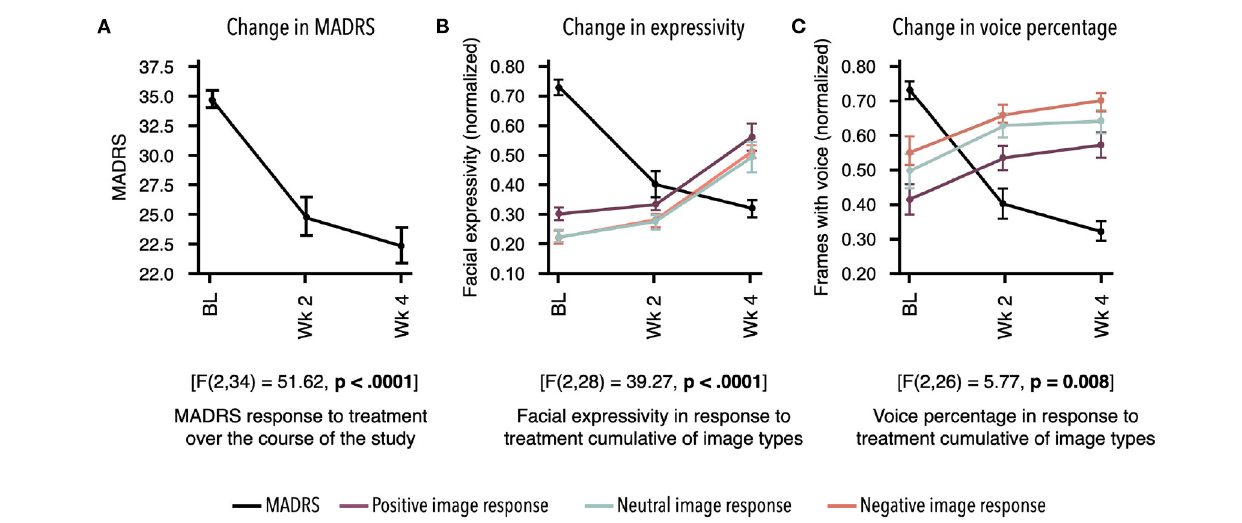
FIGURE 2 | Response to treatment as measured by two independent assessments. Mean for each time point and standard error bars are shown. Results demonstrate treatment’s significant effect on digital markers, which are highly concordant with change in depression symptom severity. (A) Montgomery–Åsberg Depression Rating Scale (MADRS) scores acquired at baseline (BL), week 2, and week 4 showed significant decrease in response to antidepressant therapy (ADT) [ F (2, 34) = 51.62, p < 0.0001]. (B) Overall facial expressivity measured in response to positive [ F (2, 28) = 40.66; p < 0.0001], neutral [ F (2, 28) = 32.6; p < 0.0001], and negative [ F (2, 28) = 36.95; p < 0.0001] images demonstrated a significant increase in response to ADT as MADRS scores decreased. (C) Percentage of frames with voice measured in response to positive [ F (2, 26) = 3.59; p = 0.04], neutral [ F (2, 26) = 5.59; p 0.009], and negative [ F (2, 28) = 4.65; p = 0.02] images also demonstrated a significant increase in response to ADT as MADRS scores decreased. All values in (B,C) were normalized between 0 and